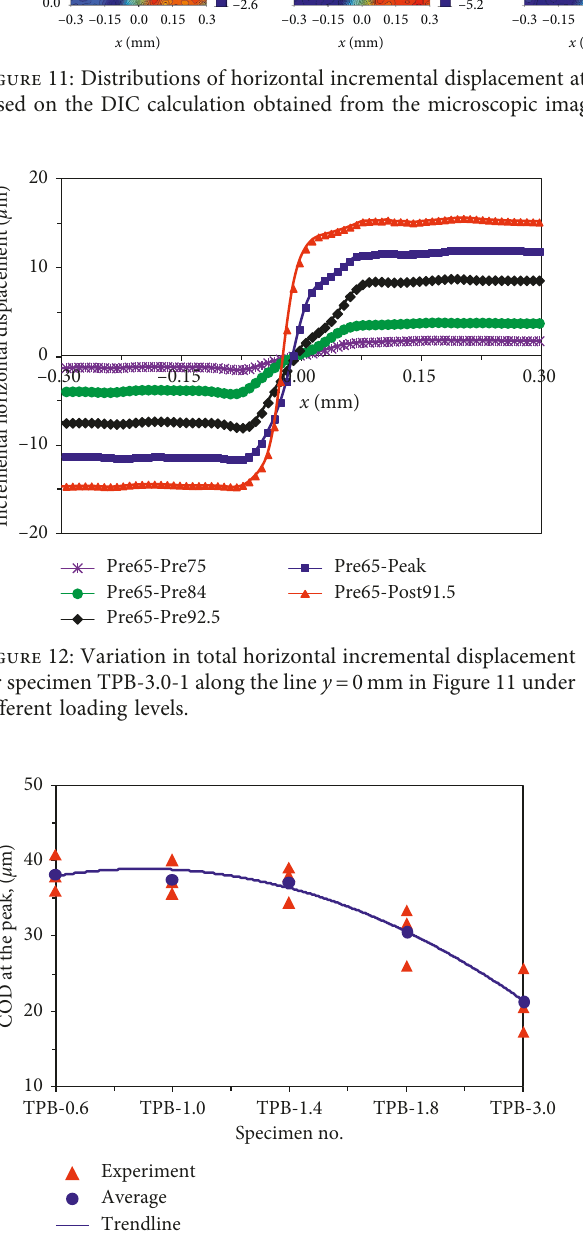
Figure 13: The total incremental CODs at the peak under five loading rates determined by